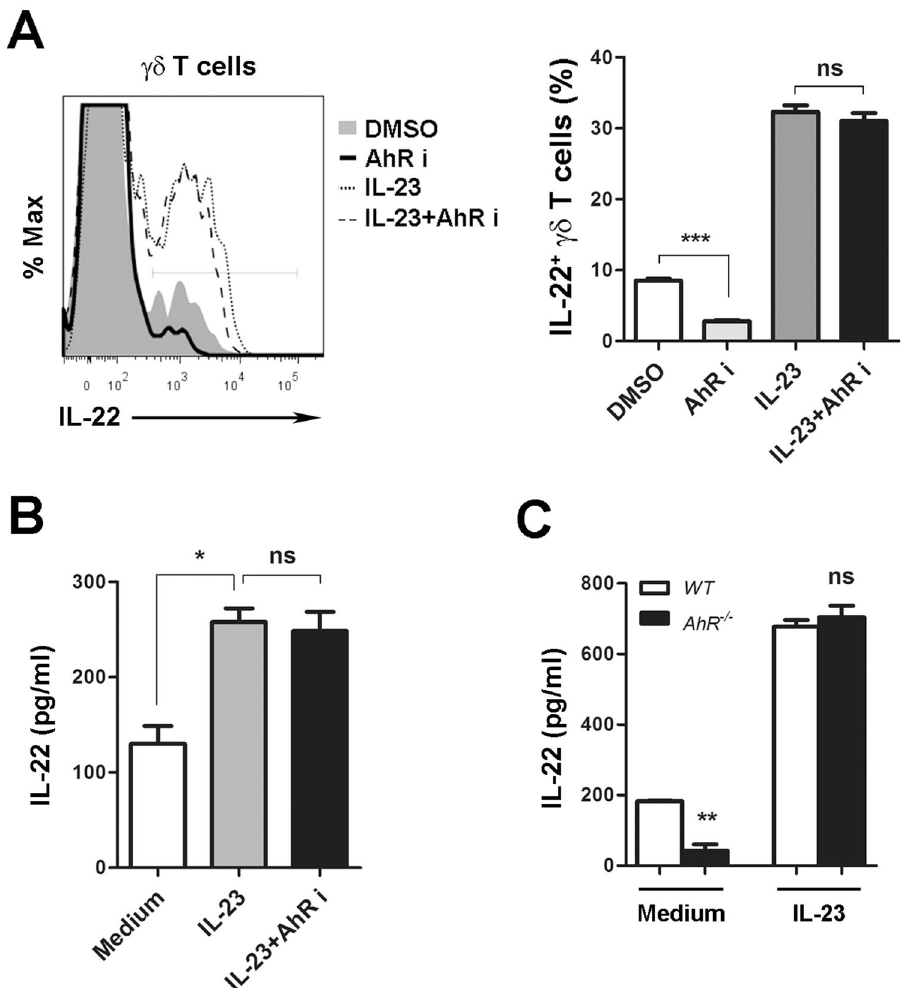
Figure 3. IL-22 expression in γδ T cells is independent of AhR signaling in the presence of IL-23. ( A and B ) Clone 13-induced IHLs at 3 dpi were cultured at the indicated conditions overnight. IL-23 (20 ng/ml); AhR i (3 μ M), AhR inhibitor. ( A ) The percentage of IL-22-expressing γδ T cells was tested by flow cytometry. ( B ) IHLs were incubated under described conditions in vitro for 3 days, and then IL-22 levels in the supernatant were examined with ELISA. ( C ) IHLs from WT and AhR − / − mice were incubated with Clone 13 (1 × 10 6 pfu/ ml) and stimulated with or without IL-23 (20 ng/ml) in vitro for 3 days. IL-22 levels in the supernatants were determined by ELISA. Data are representative of two independent experiments. The results are expressed as the mean ± SEM ( n = 3). * p < 0.05; ** p < 0.01; *** p < 0.001. ns, no significant